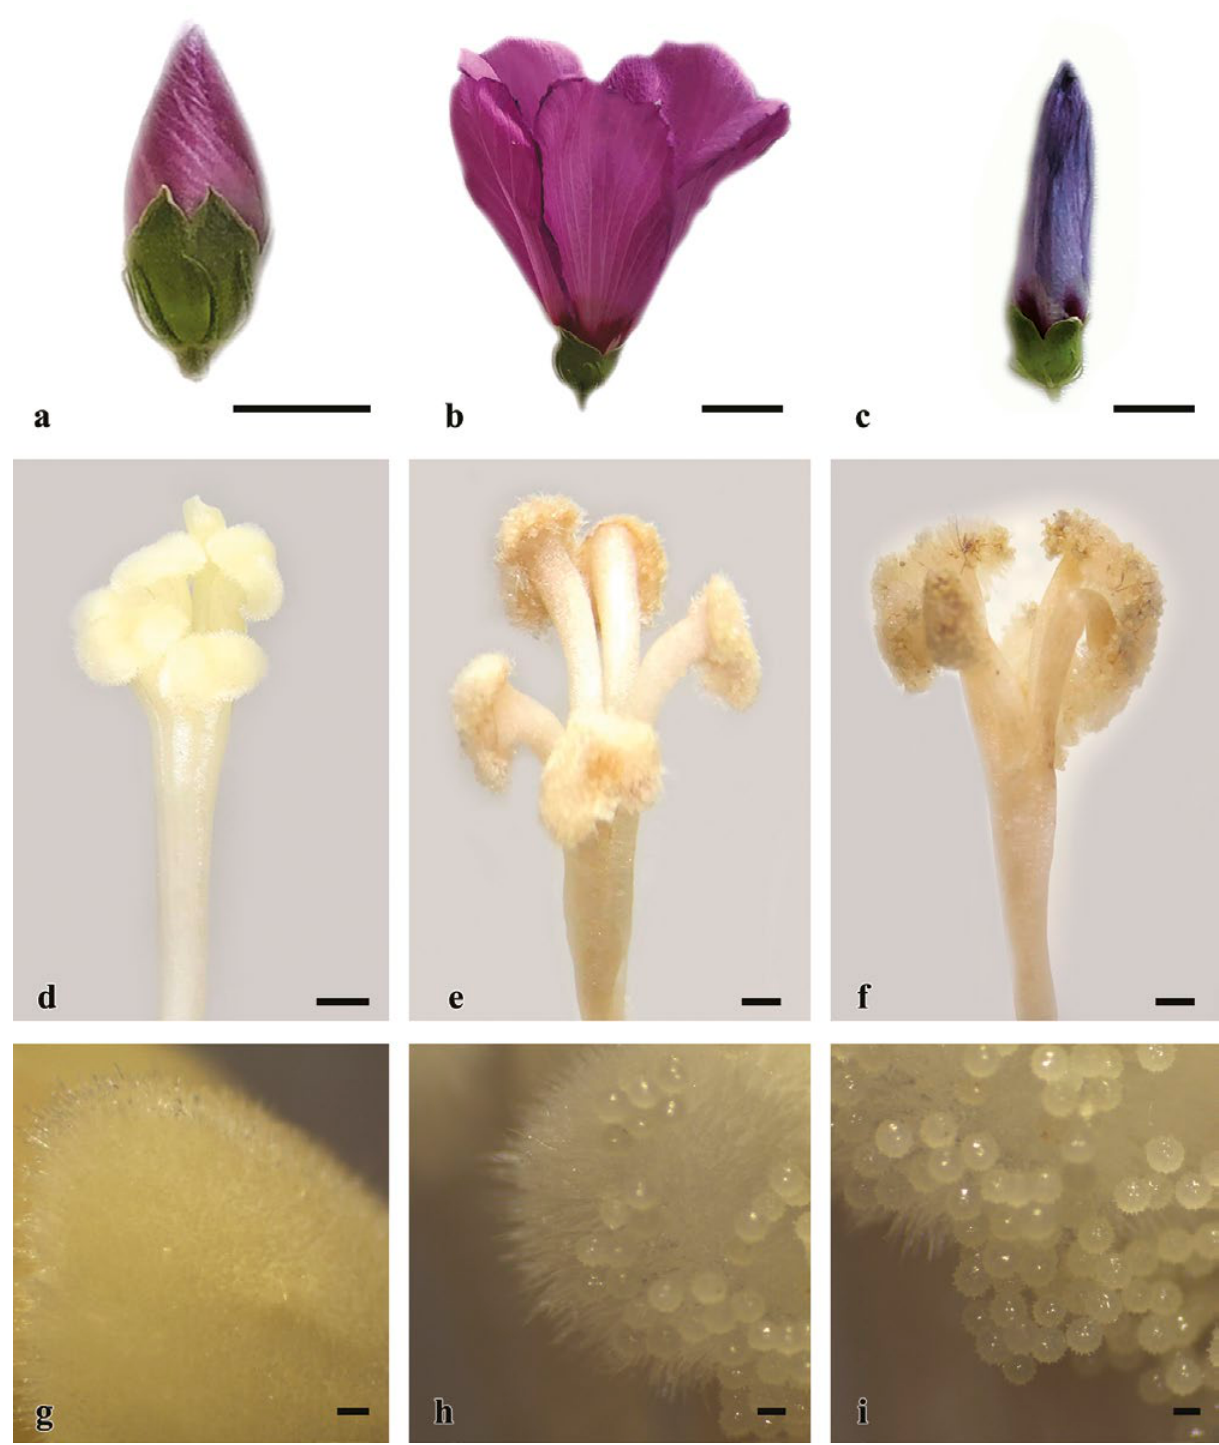
Figure 1. Determination of development stages of flower and stigma in Hibiscus syriacus . Flower morphology at pre-anthesis (a), anthesis (b), post-anthesis (c). Stigma morphology at pre-anthesis (d), anthesis (e), post-anthesis (f). Stigmatic surface at pre-anthesis (g), anthesis (h), post-anthesis (i). Scale: 1 cm in a-c, 1 mm in d-f and 100 µm in